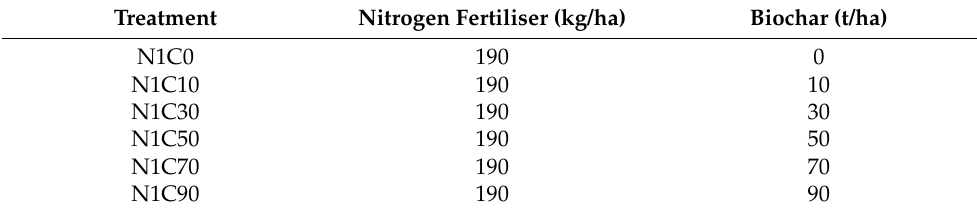
Table 2. Treatments of different biochar and fertilisation